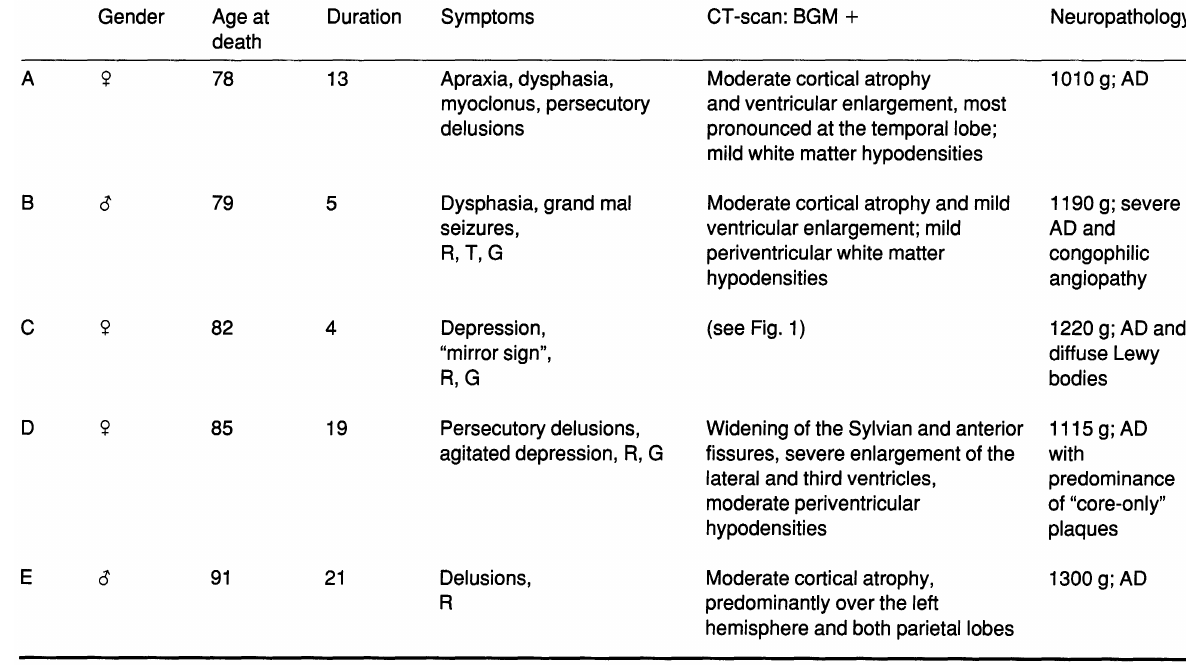
TABLE I. A summary of clinical, neuroradiological and neuropathological findings of the patients with histologically verified Alzheimer's disease and bilateral basal ganglia mineralization (BGM)